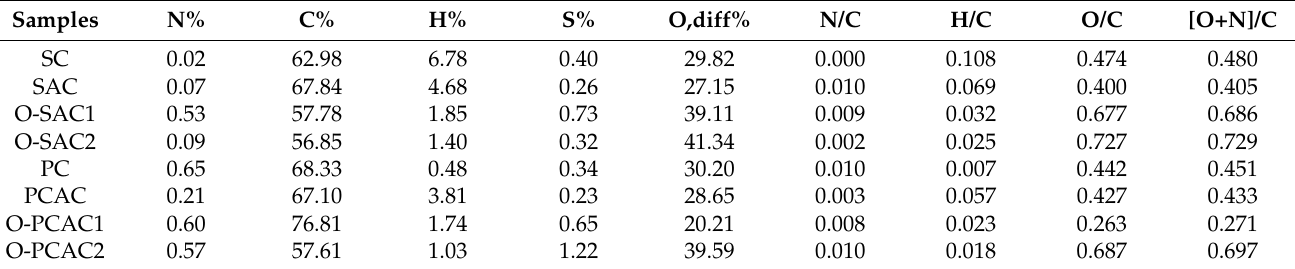
Table 3. The elemental composition of